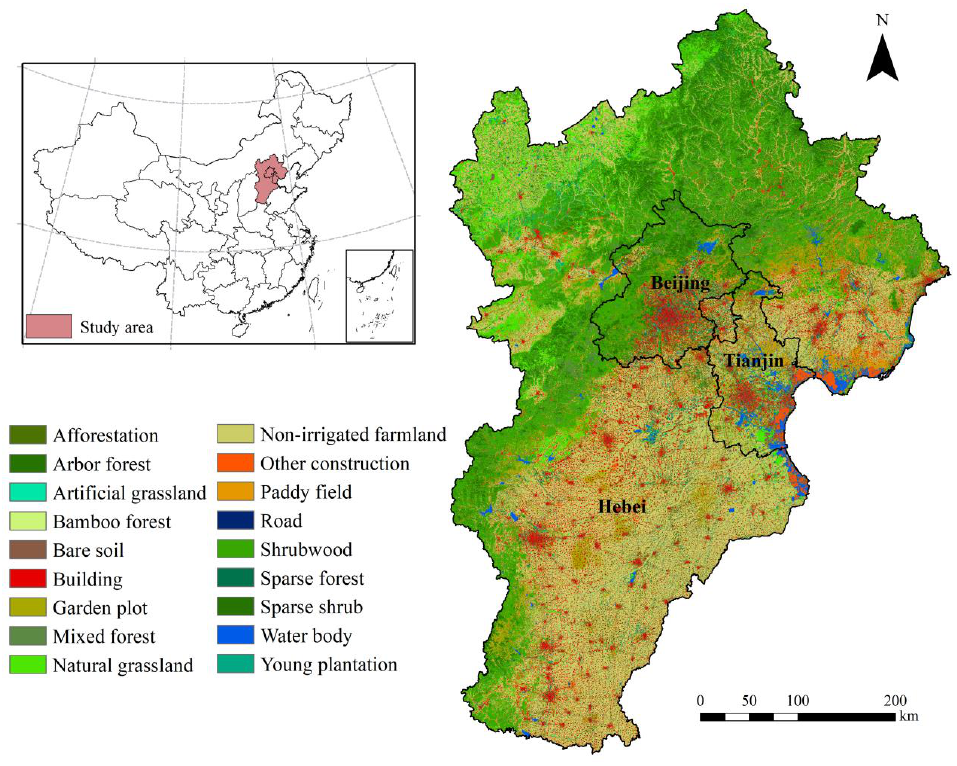
Figure 1. Geographical location and land-cover types of BTH.